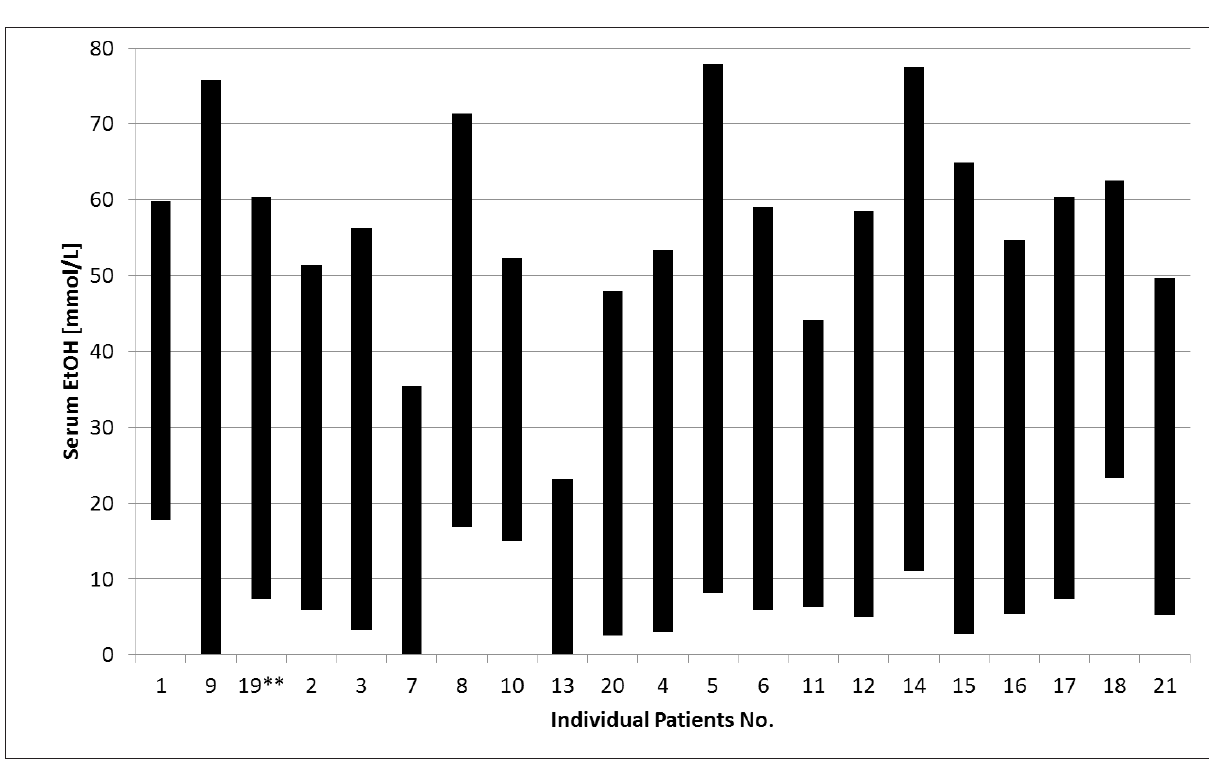
Fig. 1. Highest and lowest serum ethanol levels measured for each patient. Upper-end of boxes present the high- est serum ethanol concentrations measured during the observation period; lower-end of boxes present the lowest serum ethanol concentrations measured during the observation